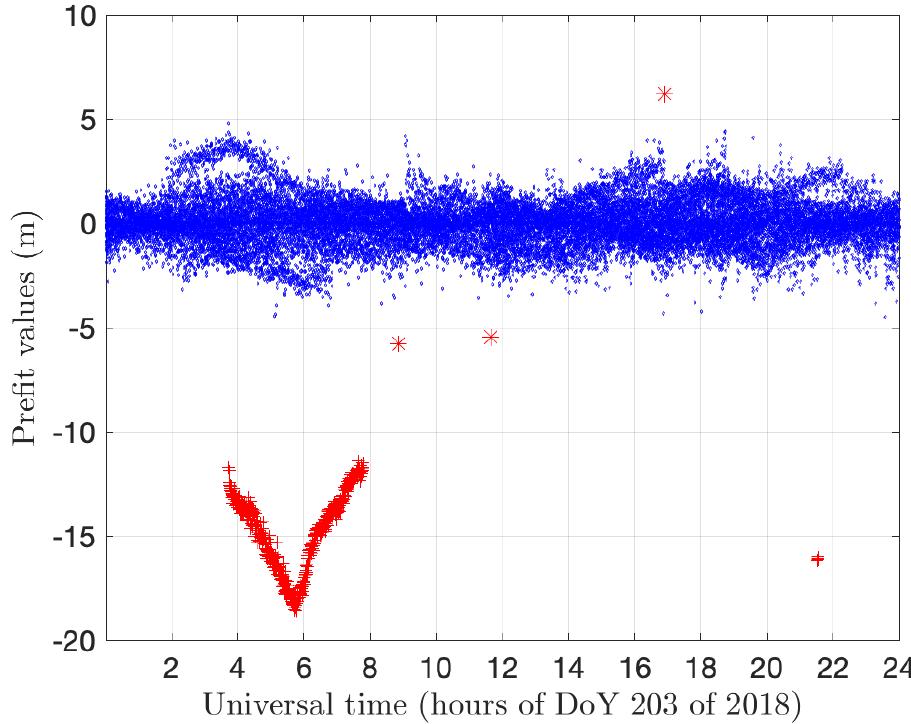
Figure 2. Dataset from 4th November 2018 (day 203 of year 2018). A single application to all data of LMS, re-weighted LTS and FS produces the outliers in red. More precisely, the red ‘ + ’ symbols are detected by all methods, while LMS also detects the red ‘ ∗ ’ associated to an absolute pre-fit of about 5 m. FS is applied in the standard form, calibrated to simultaneous 1% confidence level while, to ensure same significance, we corrected the LMS and LTS with